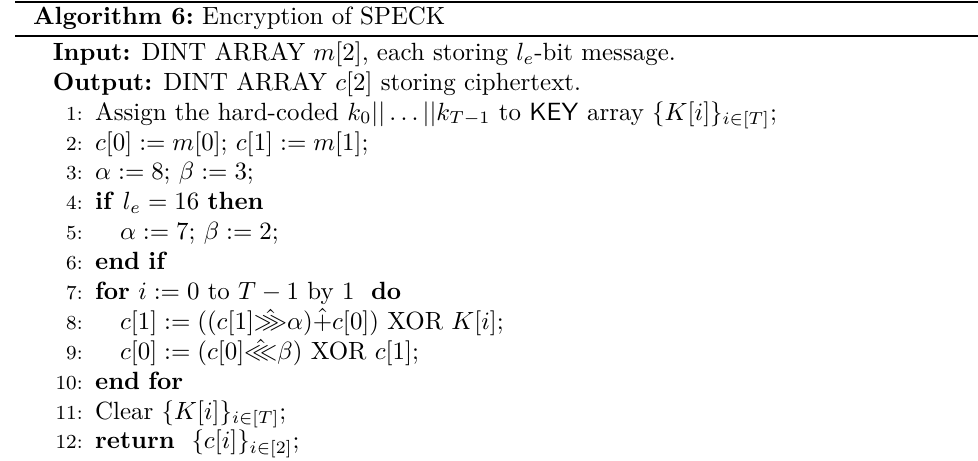
Algorithm 6: Encryption of SPECK